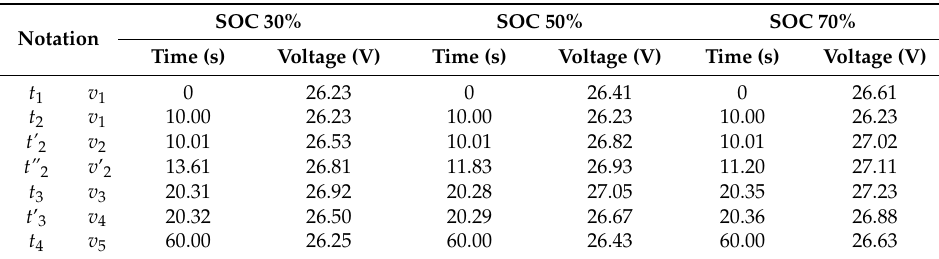
Table 4. Records of voltages and times.